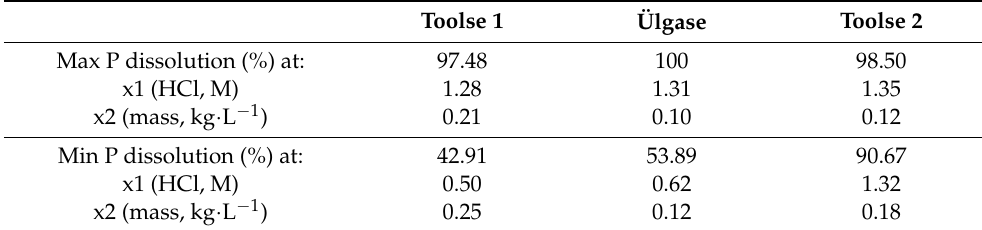
Table 7. Calculated values of parameters for P solubility